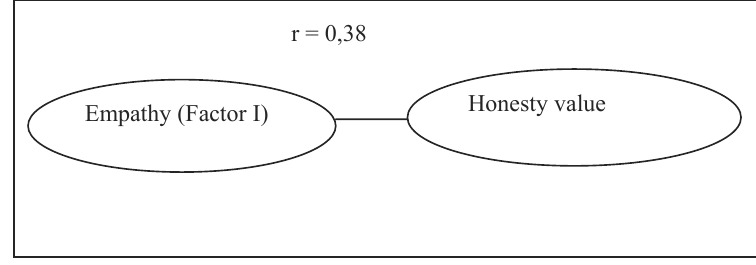
Fig. 1.4. Correlation between empathy (Factor I) and honesty value.